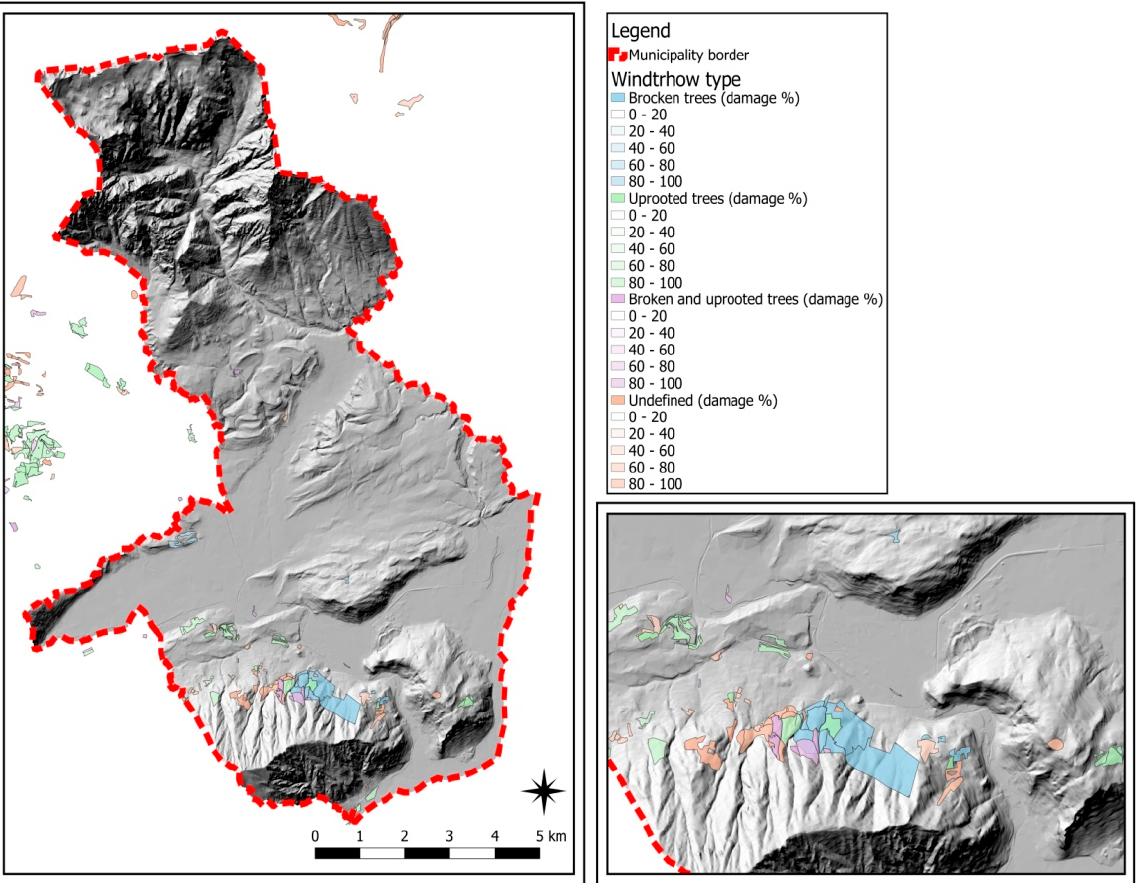
Figure 16. Map of windthrown types, which are differentiated into four categories: broken trees in blue, uprooted trees in green, broken and uprooted trees in purple, and undefined trees in brown. The increasing percentage of windthrown is represented for each category with the abovementioned brighter colours.